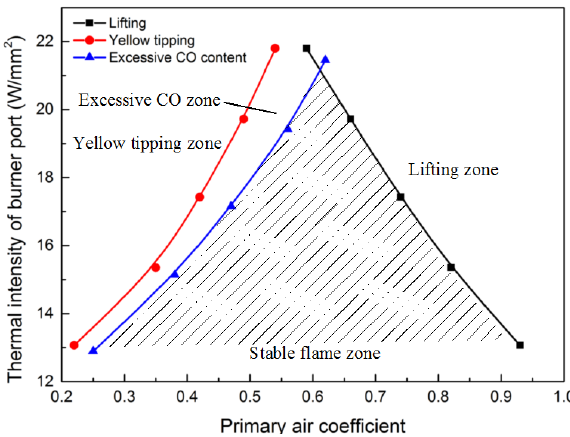
Figure 9. Flame stability diagram for the substitute gas. Energies 2017 , 10 , 1902 Table 7. Flame stability testing data of the comparative gas.